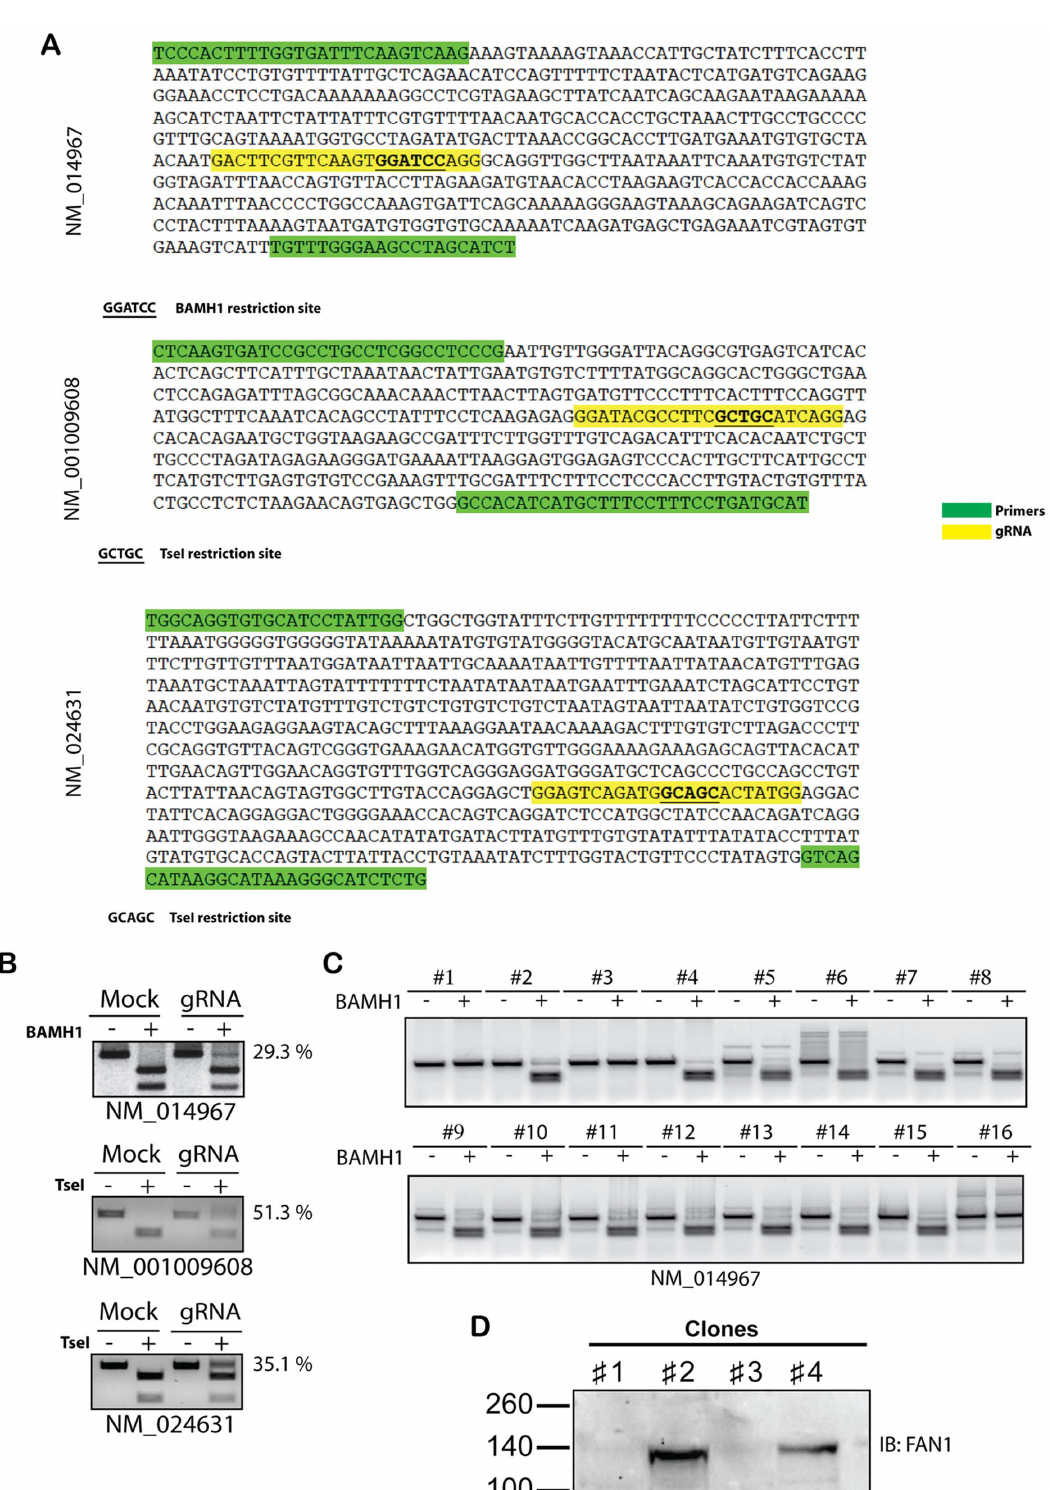
Figure 2. Analysis of gene targeting. ( A ) Sequences corresponding to the PCR products used to analyze the mutation of the targeted sites. Primer sequences and target sites are respectively highlighted in green and yellow. The restrictions sites used to analyze mutation of the targeted sequences are underlined and in bold. ( B ) PCR was performed using DNA isolated from a pool of U2OS SEC-C that had been transfected with the indicated sgRNA. PCR products have been purified and digested or not with the indicated enzymes. The indicated percentages represent the relative intensity of the top band of lane 4. Band intensities have been quantified using Image J software on three independent experiments ( C ) DNA isolated from single cell colonies was analyzed using the primers shown in Figure 2A. ( D ) Cell clones were analysed by western blot using an antibody against FAN1, the protein encoded by NM_014967.